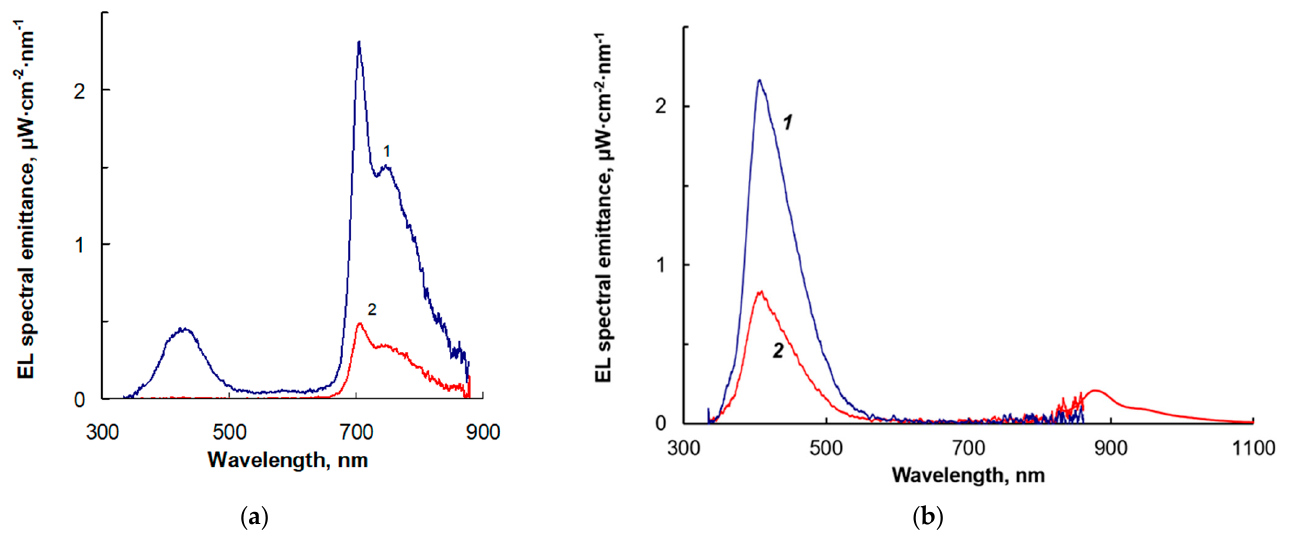
Figure 9. EL spectra of the OLEDs based on the PVK:PBD:dye composites with ( a ) Cu ‐ PP ‐ IX of the concentration of 1 wt.% ( 1 ) and 5 wt.% ( 2 ) at an applied voltage of 25 V, and ( b ) Cu ‐ C ‐ e6 of the concentration of 1 wt.% ( 1 ) and 2 wt.% ( 2 ) at an applied voltage of 15 V.